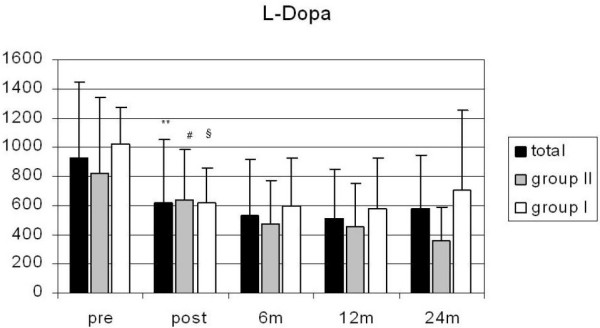
L-dopa equivalents (mg) in all patients as well as in groups I and II preoperatively and at the different postoperative follow-up times; significant differences between pre- and postoperative state in all groups (**, #, § p < 0.01), 24 m group I: ns.